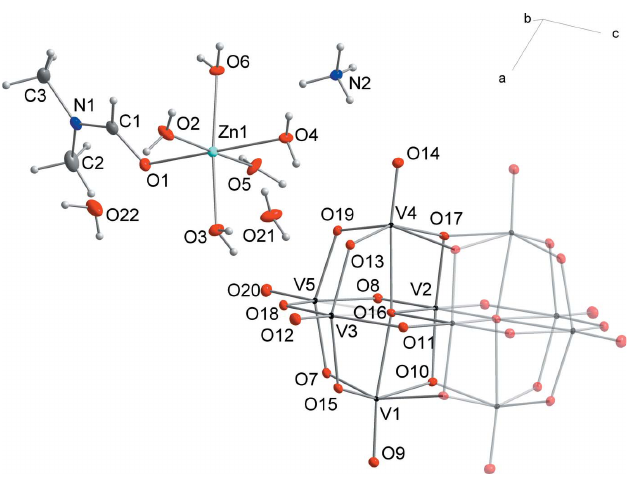
Figure 1 The molecular structure of 1 showing 50% displacement ellipsoids illustrated with DIAMOND (Brandenburg & Putz, 2005). The half of the decavanadate anion that is not part of the asymmetric unit is displayed as faded.